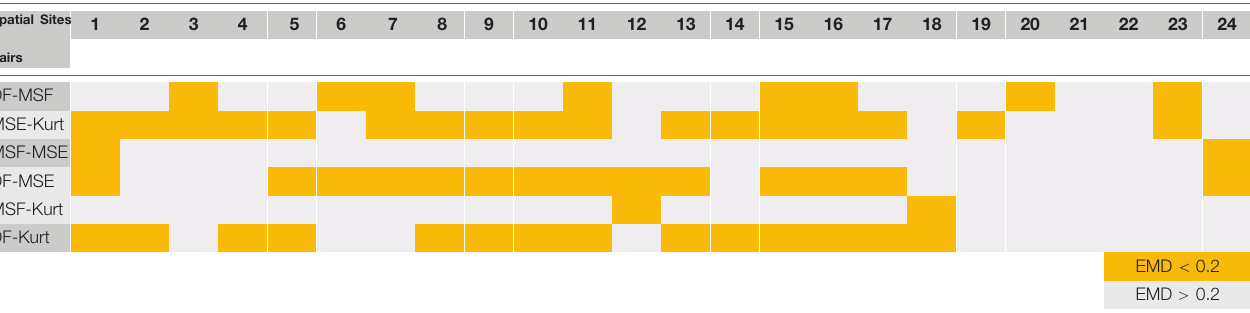
TABLE 2 | Earth mover’s distance correlation between different pairs of approaches for various spatial sites of a representative patient P8 with successful AF termination (from Figures 2 , 4 ).